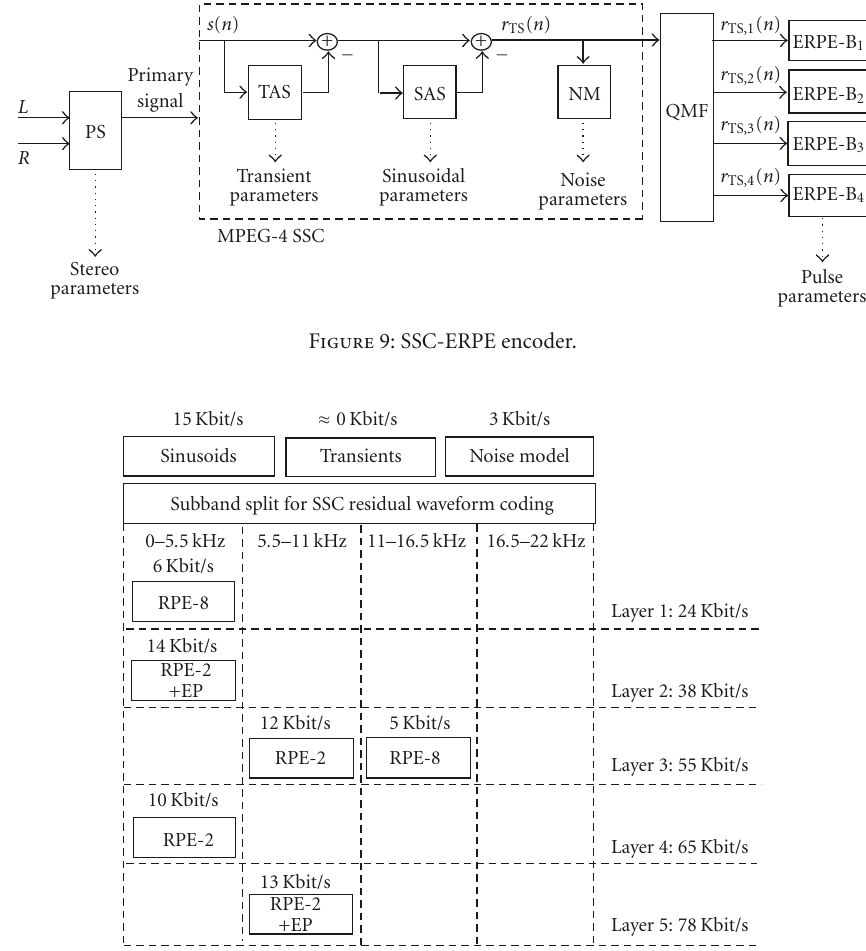
Figure 10: Bit rates (mono) distribution among the five SSC-ERPE extension layers.